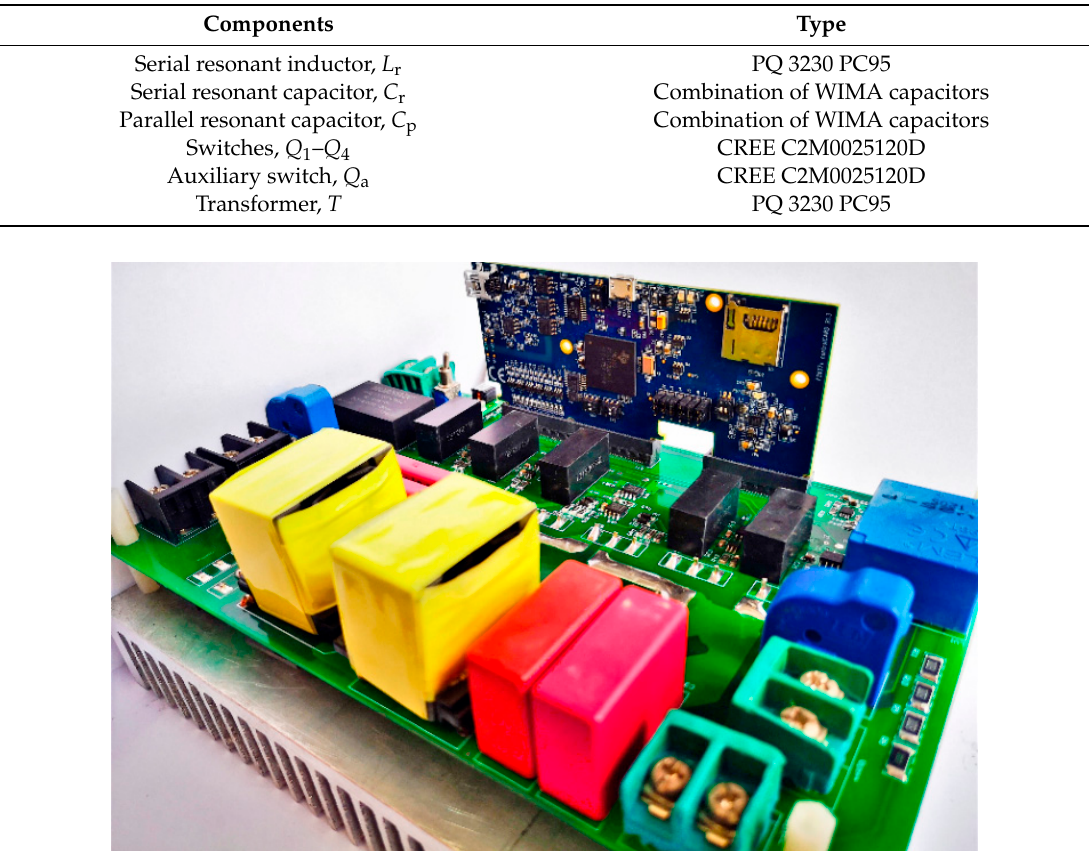
Figure 11. Photograph of the prototype built in the laboratory. Table 1. Main components of the proposed converter.